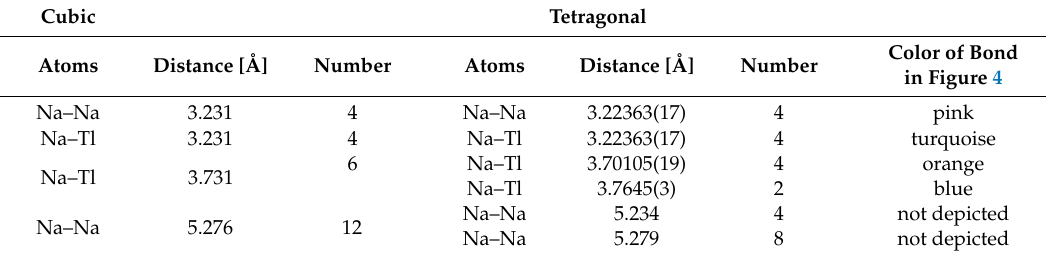
Table 5. Distances in the cubic and tetragonal systems. Tl–Tl distances are equal to the Na–Na distances and therefore not explicitly